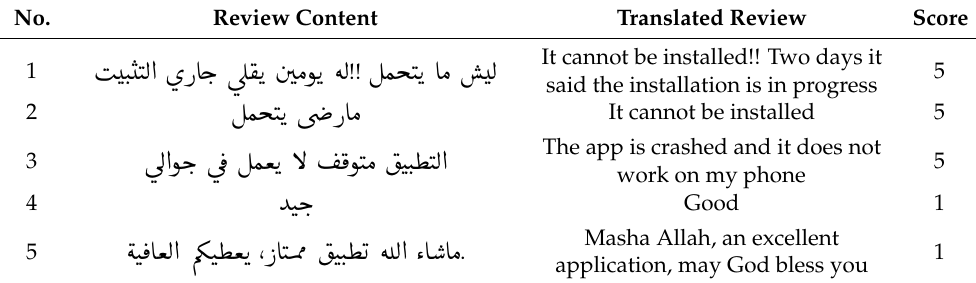
Table 3. Review sample from the dataset with a misleading score assigned by a user.